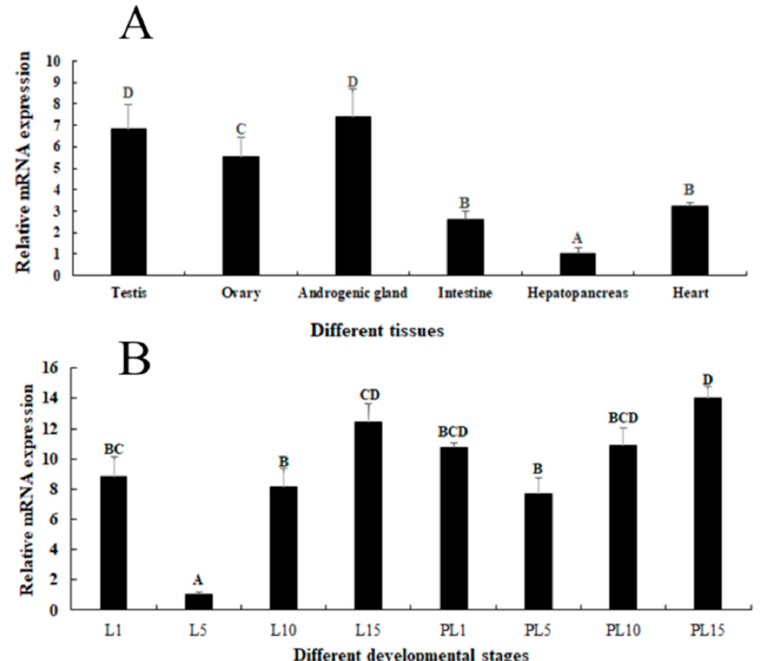
Figure 3. Expression characterization of Mn-GEM in di ff erent tissues and developmental stages. The amount of Mn-GEM mRNA was normalized to the eukaryotic translation initiation factor 5A ( EIF ) transcript level. Data are shown as mean +SD (standard deviation) of tissues from three separate individuals. Capital letters indicate expression di ff erence between di ff erent samples. ( A ) Expression characterization in different tissues. ( B ) Expression characterization in different developmental stages.